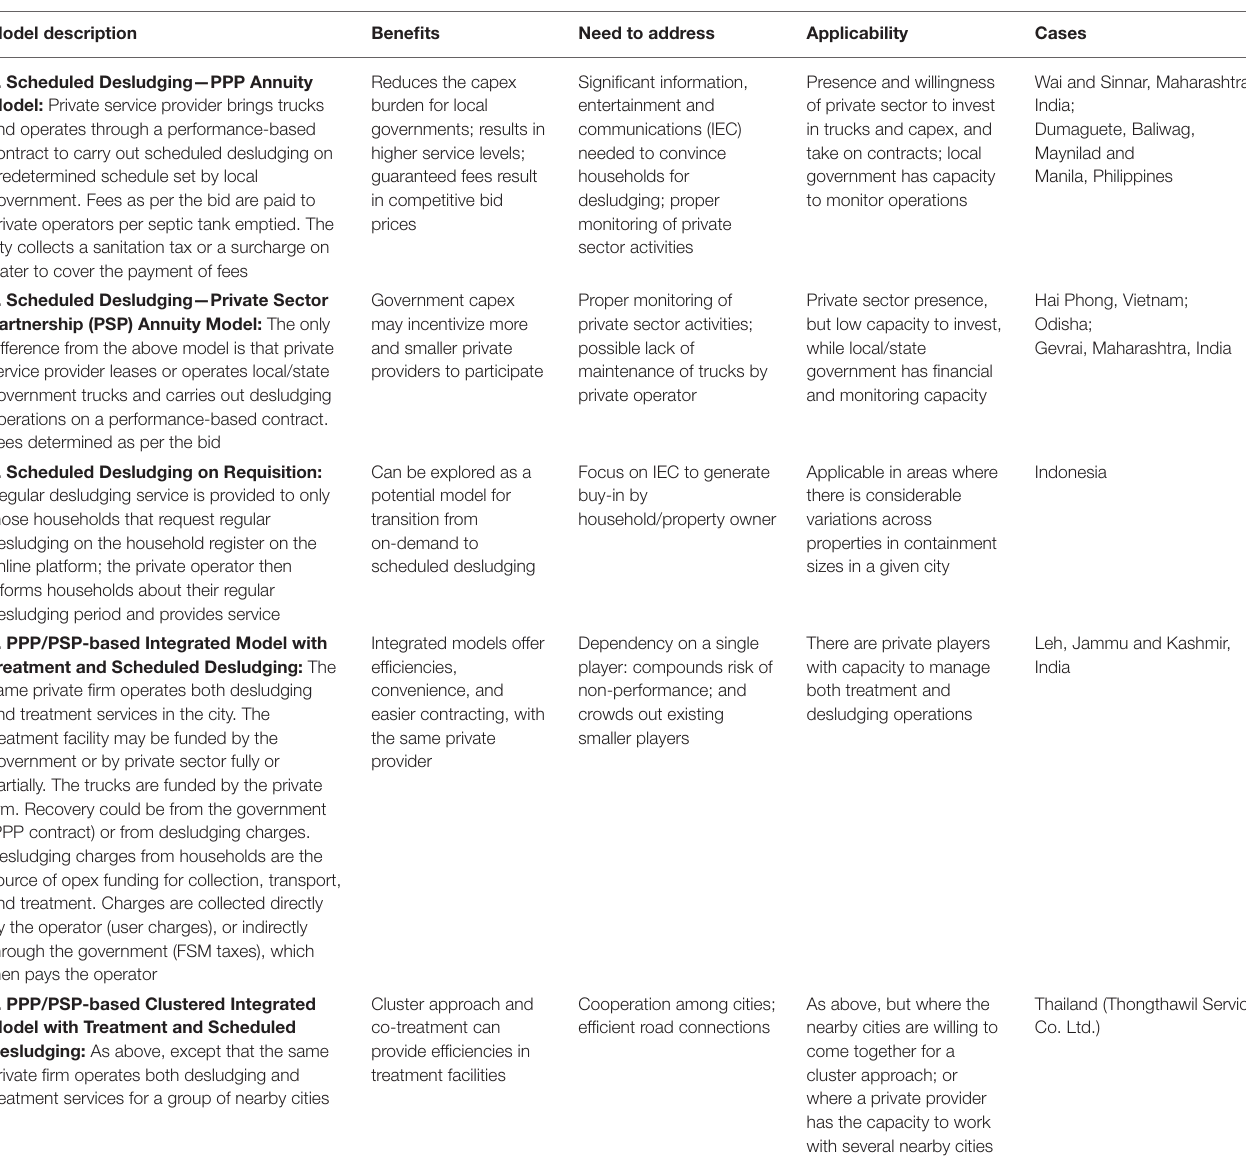
TABLE 2 | Service/Business Models for Scheduled